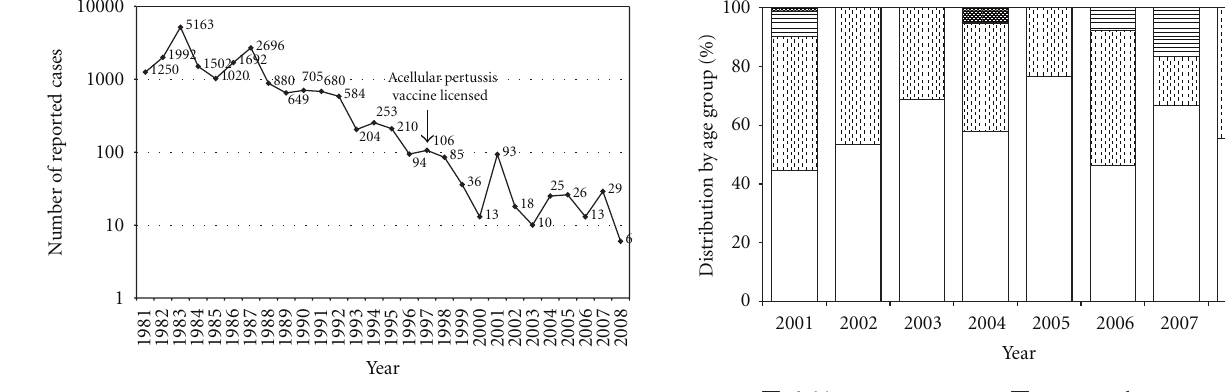
Figure 1: Semilogarithmic diagram of notified pertussis cases by year in Greece (1981–2008).